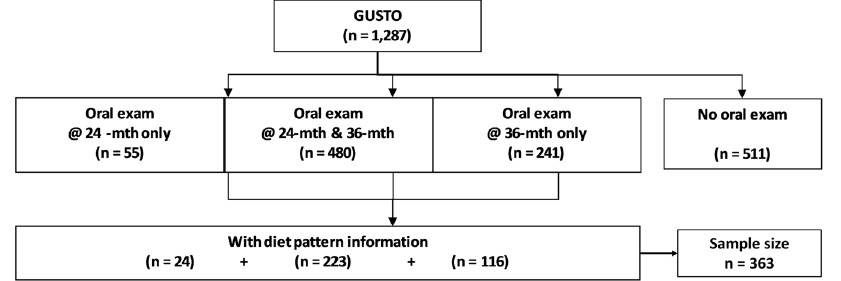
Figure 1. Summary of study subjects included from the GUSTO